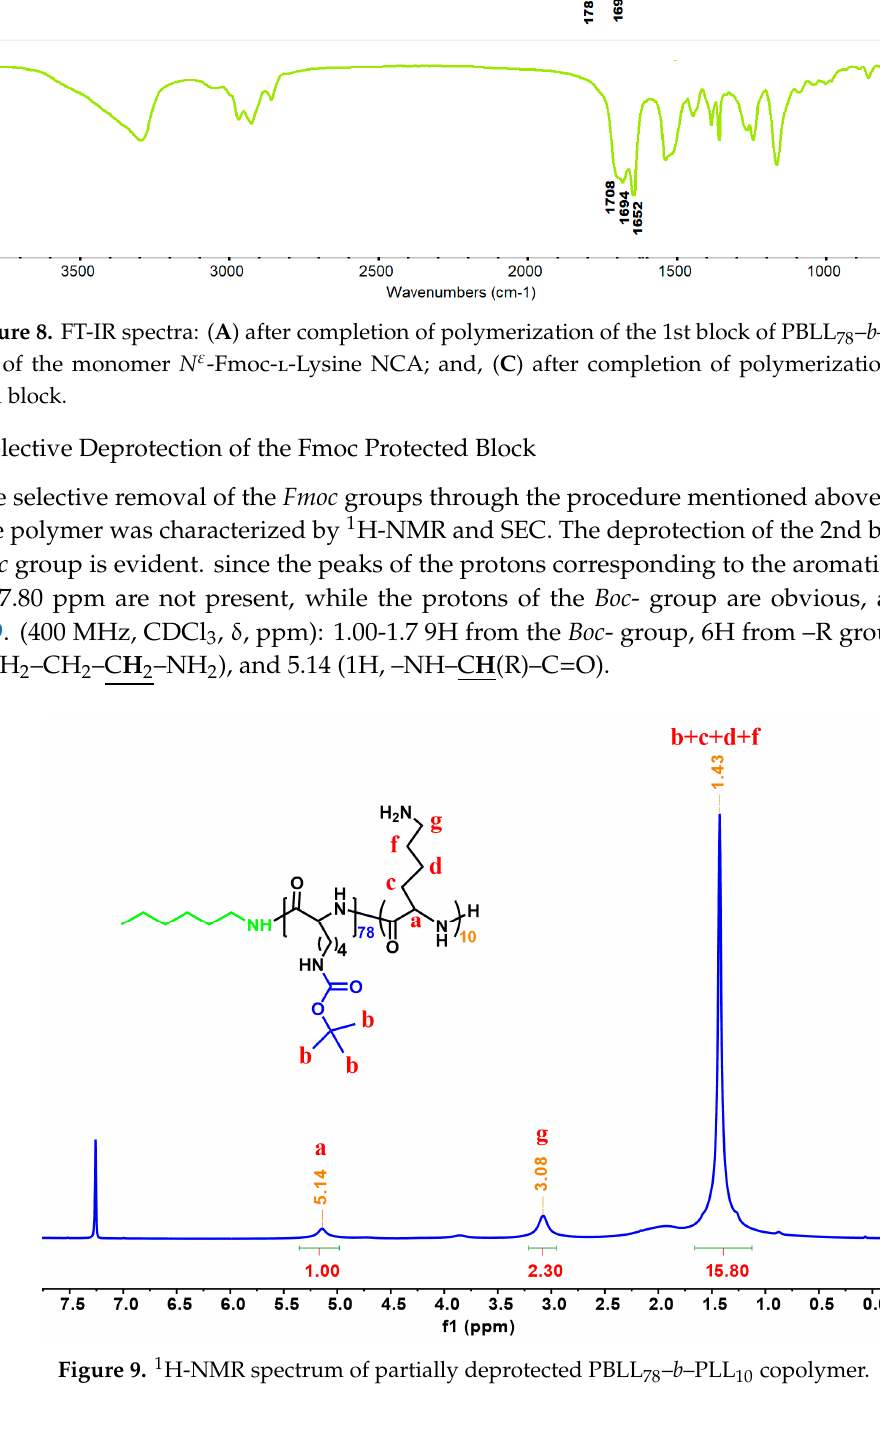
Figure 10. SEC eluogram of partially deprotected PBLL 78 – b –PLL 10 copolymer. The SEC eluogram presented in Figure 10 was measured in DMF/LiBr solvent. Although the deprotected PLL block is not completely soluble in this solvent, no aggregation occurred, and a monomodal peak was present. The molecular weight of PBLL 78 – b –PLL 10 obtained was M n = 19.4 × 10 3 g mol –1 , while the stoichiometrically expected molecular weight was 18.1 × 10 3 g mol –1 . The polydispersity index was 1.17. Scheme 8 depicts the synthesized graft copolypeptides.